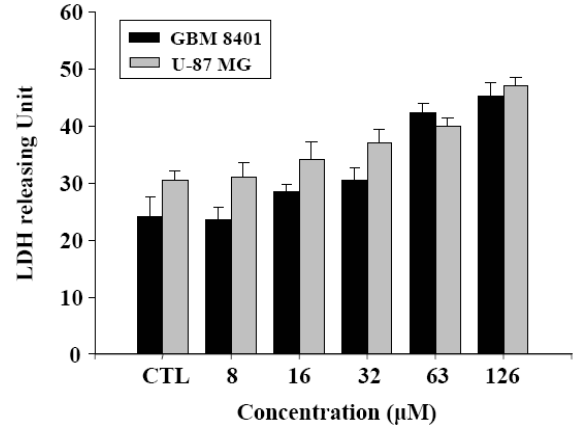
Figure 5. LDH releasing unit of γ -mangostin treatment in human glioblastoma cells. To evaluate the different doses of γ -mangostin, cell damage was observed for 24 hours on glioblastoma cell lines. The LDH activity in the supernatant of cells was determined by an indirect colorimetric assay. One unit of LDH released represents the generation of 1 μ mol NADH through the reduction of 1 μ mol L -lactate and then generated NADH which conversed and depended on 2-[4-iodophenyl]-5-phenyltetrazolium chloride (INT) by diaphorase at room temperature [20] .